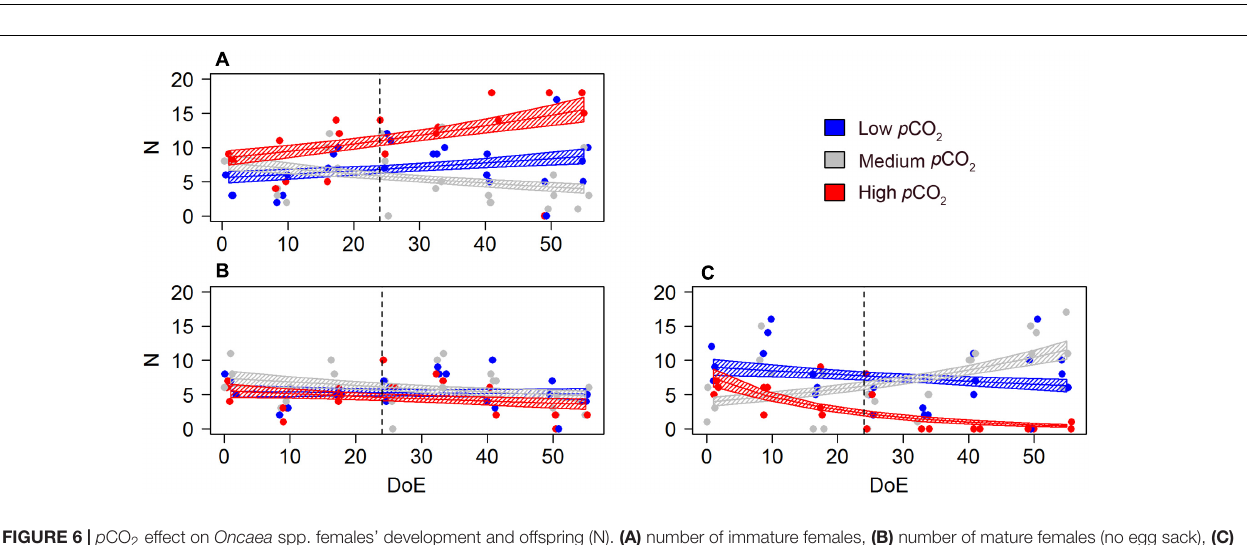
FIGURE 5 | Oncaea spp. abundances during the study period. (A) Adults, (B) copepodites. Color code: blue = low- p CO 2 (M1, M5, and M9), gray = medium- p CO 2 (M3, M4, and M7), red = high- p CO 2 (M2, M6, and M8). DoE, day of experiment. Numbers represent abundances per mesocosm (e.g., 9 for M9). Solid lines = prediction from Generalized Additive Mixed Models (GAMMs) (smoother trends p -value < 0.05); shaded area = confidence interval. Dashed line: t24, deep water addition.